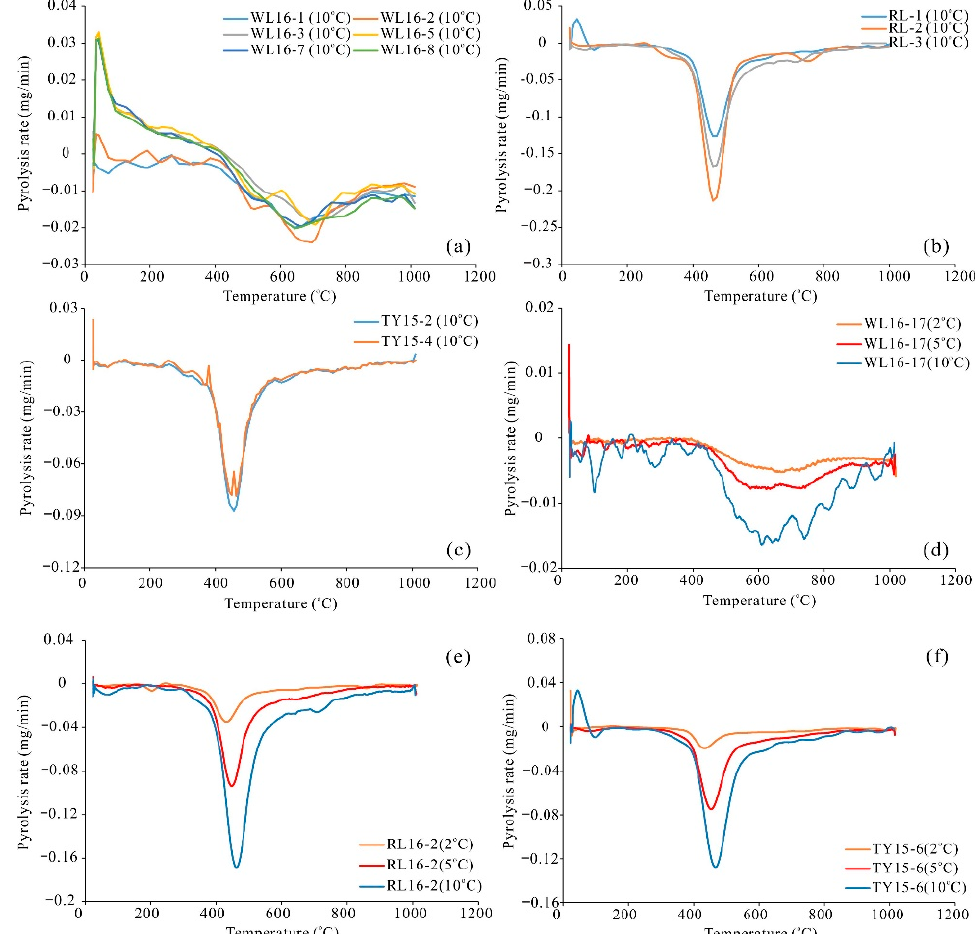
Figure 7. The pyrolysis rates at 10 °C/min ( a – c ) and various heating rates ( d – f ) of the selected coal samples from the Wolonghu, Taoyuan and Renlou coal mines in the Huaibei Coalfield.